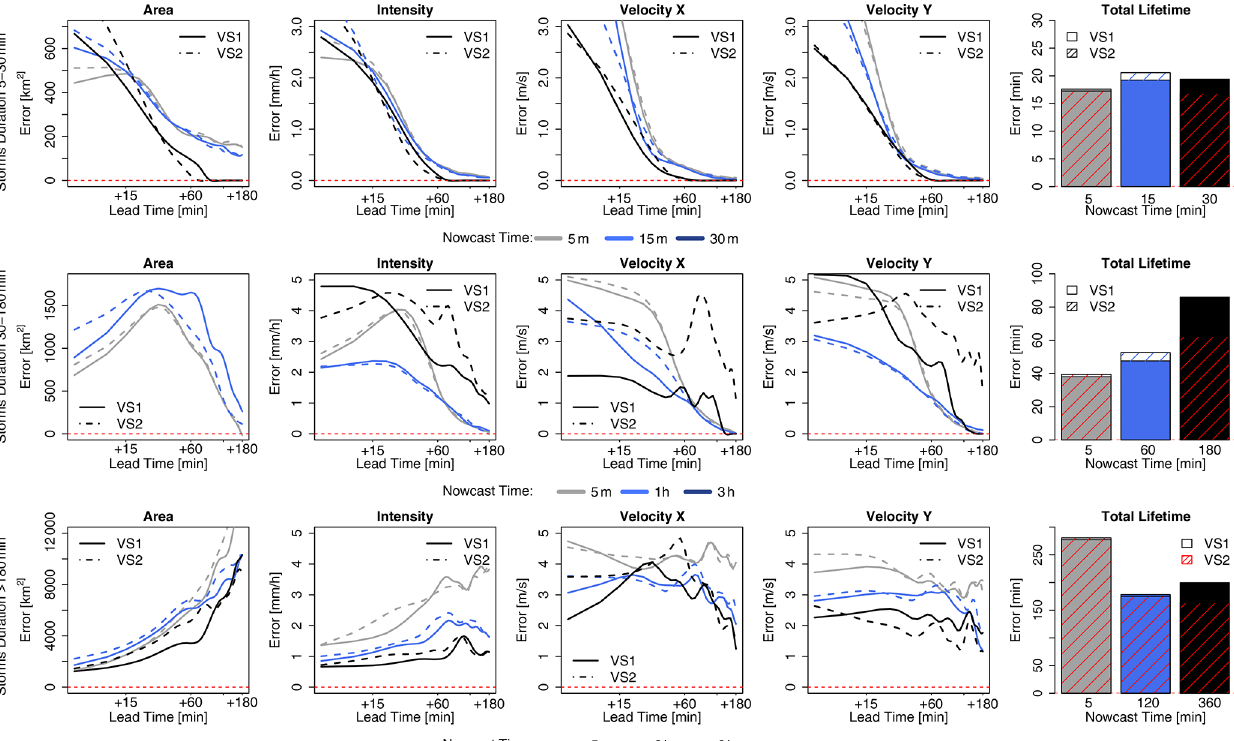
Figure 9. The median MAE over all the events for each target variable (area, intensity, and velocity in the x and y directions and total lifetime) based on two 4-NN applications: VS1 in solid and VS2 in dashed lines. The performance is shown for storms that are shorter than 30min (upper row), shorter than 3h (middle row), and longer than 3h (lower row) and over the selected nowcast times. Nowcast time dictates when the nowcast is issued relative to storm